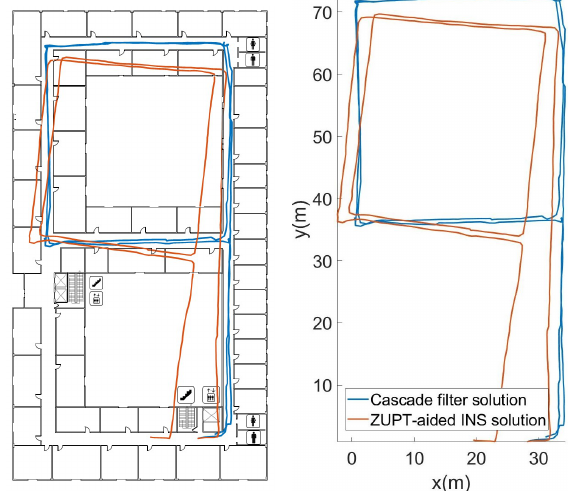
Figure 6. Trajectory restored by different algorithms.